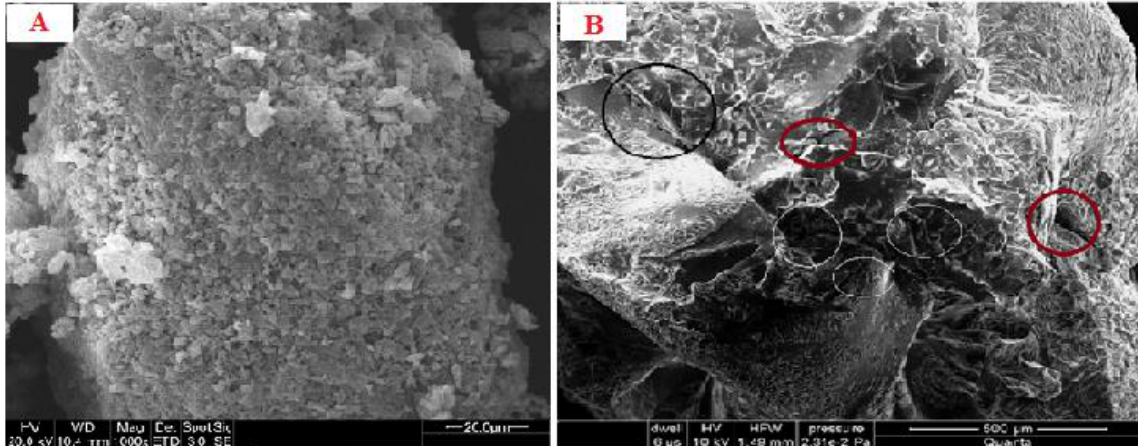
Figure 1. ( A ) SEM micrograph of blank emulgel ( B ) SEM micrograph of drug-loaded emulgel.